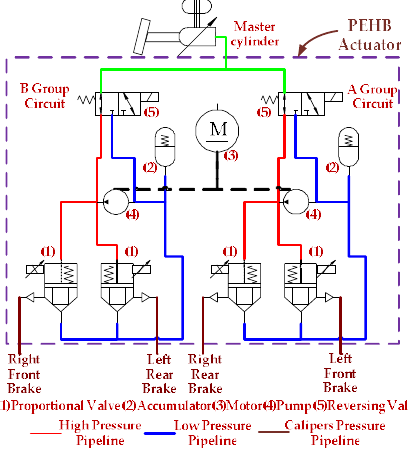
Figure 3. Proposed hydraulic circuit with a PEHB actuator.